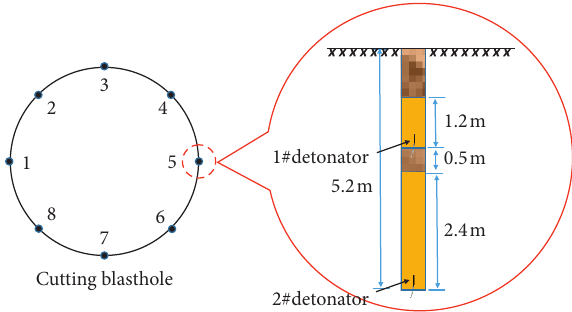
Figure 17: Schematic of cut blasting charging.